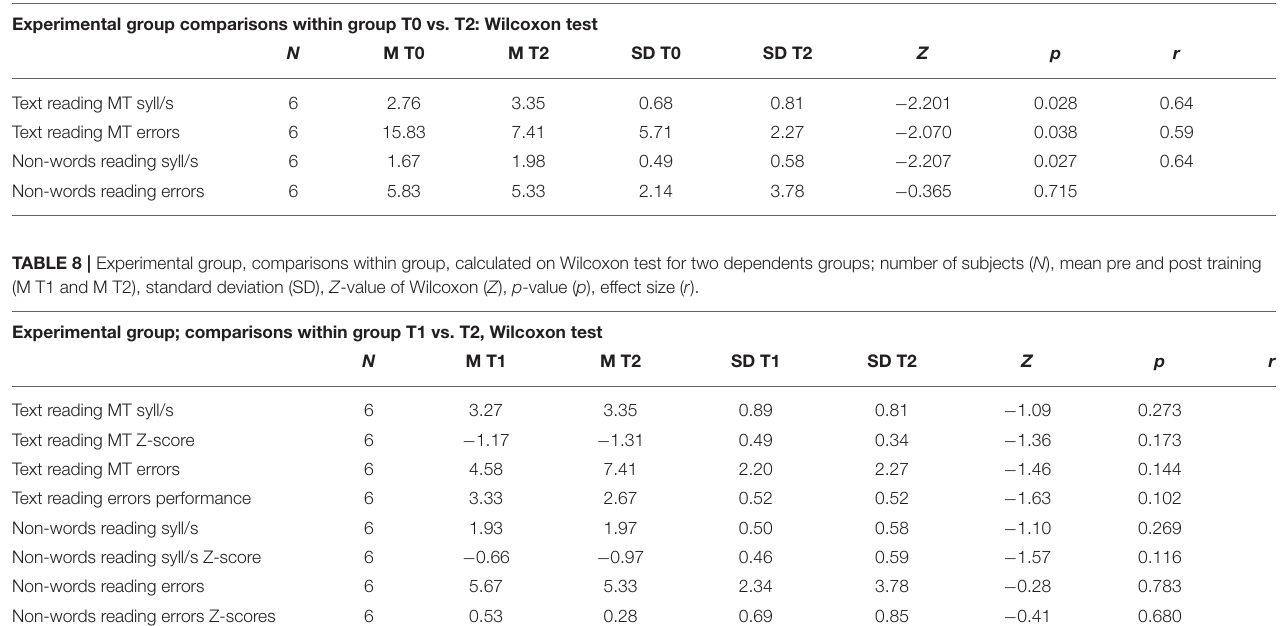
TABLE 7 | Experimental group, comparisons within group (N.6), calculated on Wilcoxon test for two dependent groups; number of subjects ( N ), mean pre and post training (M T0 and M T2), standard deviation (SD), Z -value of Wilcoxon ( Z ), p -value ( p ), effect size ( r ). Experimental group comparisons within group T0 vs. T2: Wilcoxon test N M T0 M T2 SD T0